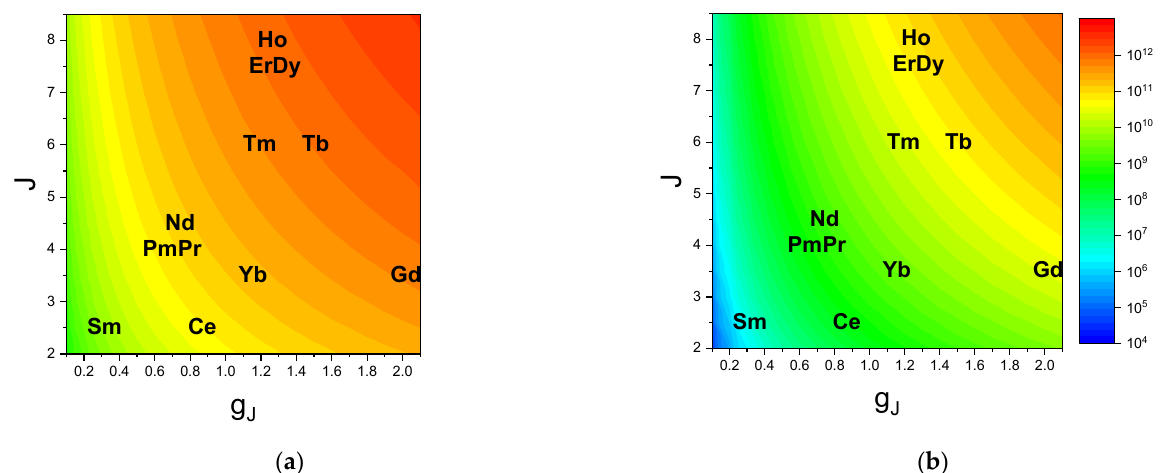
10 of 21 paramagnetic metal, in a molecule with a reorientation time (cid:2028) (cid:3019) = 10 (cid:1866)(cid:1871) , in a magnetic field of 900 MHz proton Larmor frequency. Figure 6 shows the relative magnitude of (cid:2869) (cid:2869)(cid:2873) (cid:4672) (cid:3091) (cid:3116) (cid:2872)(cid:3095) (cid:4673) (cid:2870) (cid:2011) (cid:3010)(cid:2870) (cid:1859) (cid:3011)(cid:2870) (cid:2020) (cid:3003)(cid:2870) (cid:1836)((cid:1836) + 1) and (cid:2869) (cid:2872)(cid:2873) (cid:4672) (cid:3091) (cid:3116) (cid:2872)(cid:3095) (cid:4673) (cid:2870) (cid:3082) (cid:3258)(cid:3118) (cid:3034) (cid:3259)(cid:3120) (cid:3091) (cid:3251)(cid:3120) (cid:3003) (cid:3116)(cid:3118) (cid:3011) (cid:3118) ((cid:3011)(cid:2878)(cid:2869)) (cid:3118) (cid:3038) (cid:3118) (cid:3021) (cid:3118)